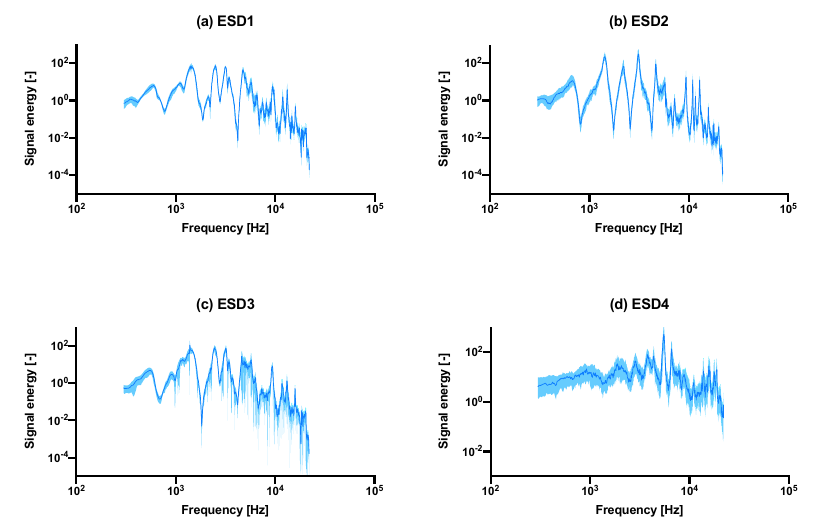
Figure 3. The median ± interquartile range (shaded) ESD plots comparison between the ( a ) last 20 hammer blows of all intact samples combined into one graph, vs. ( b ) the undersized/under-fitted broach, the ( c ) fractured samples, as well as the ESD recording from a pilot cadaver study using actual Depuy Synthes Corail components shown in ( d ). Interquartile range is shown instead of standard deviation as the distribution was asymmetrical. The same graph with a linear y -axis is shown in Supplementary Materials Figure S2.